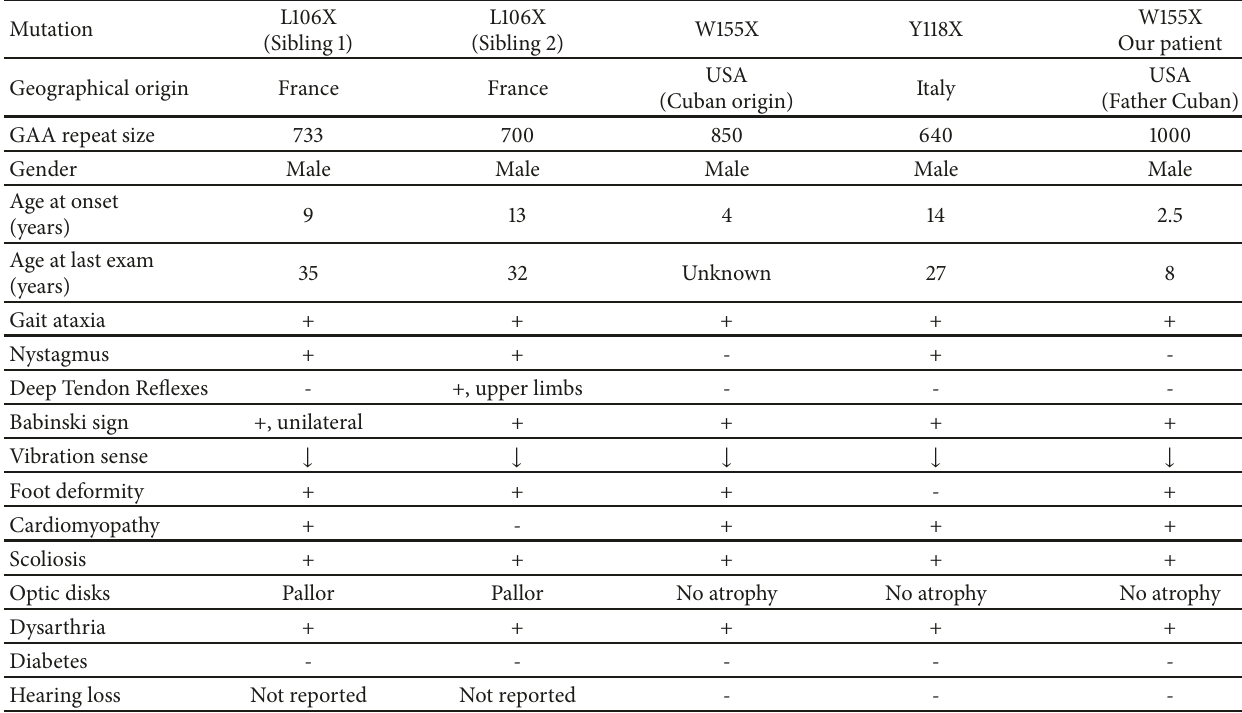
Table 1: Clinical features of Friedrich’s ataxia patients with nonsense